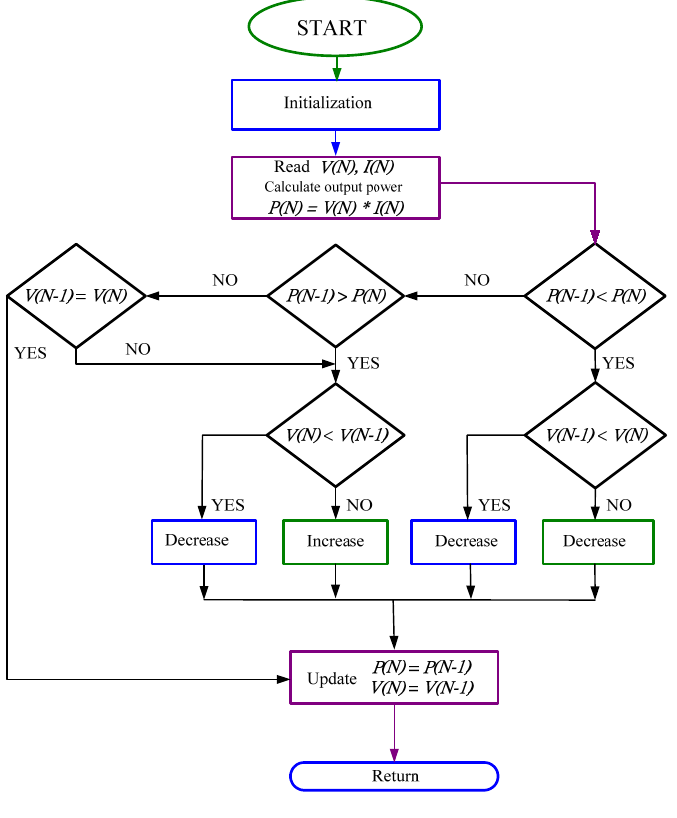
Figure 12. Flow chart of perturbation-and-observation method for MPPT